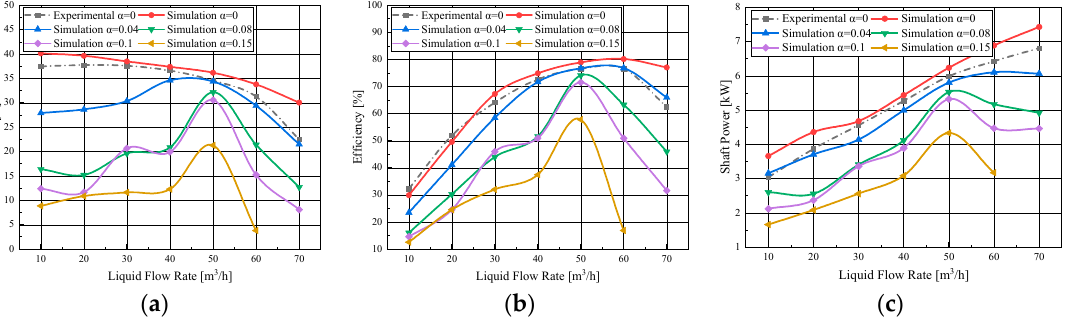
Figure 6. Effect of the inlet gas fraction on the energy performance of the pump: ( a ) flow–head curve; ( b ) flow–efficiency curve; ( c ) flow–shaft power curve.